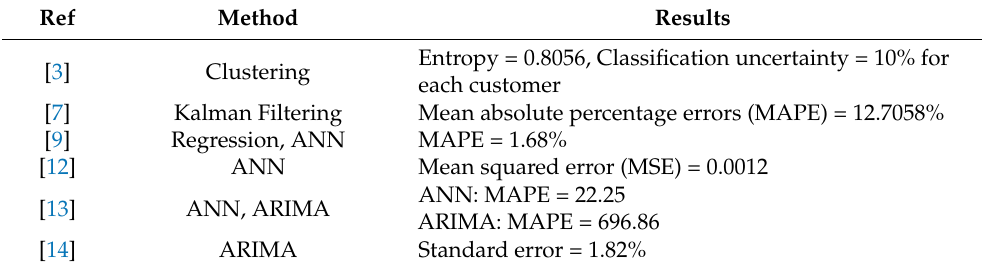
Table 1. Results